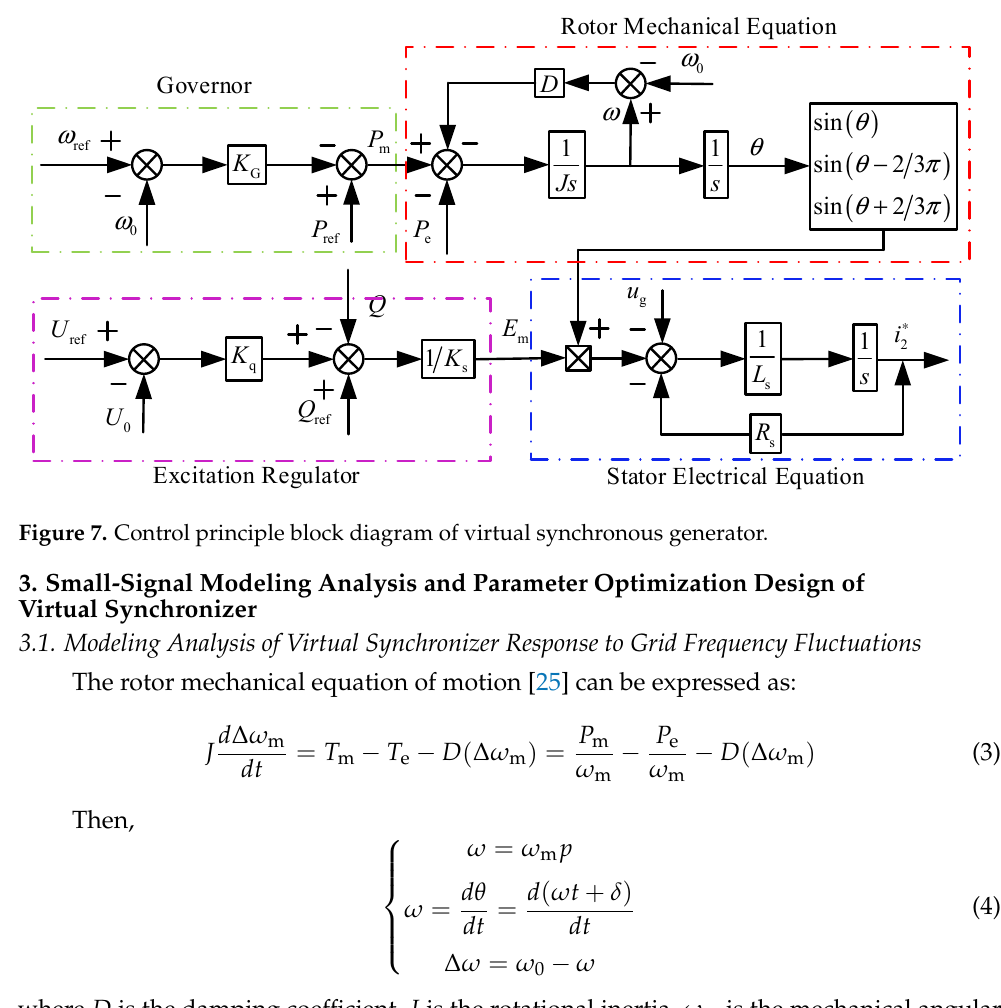
Figure 6. Block diagram of reactive power–voltage loop structure.